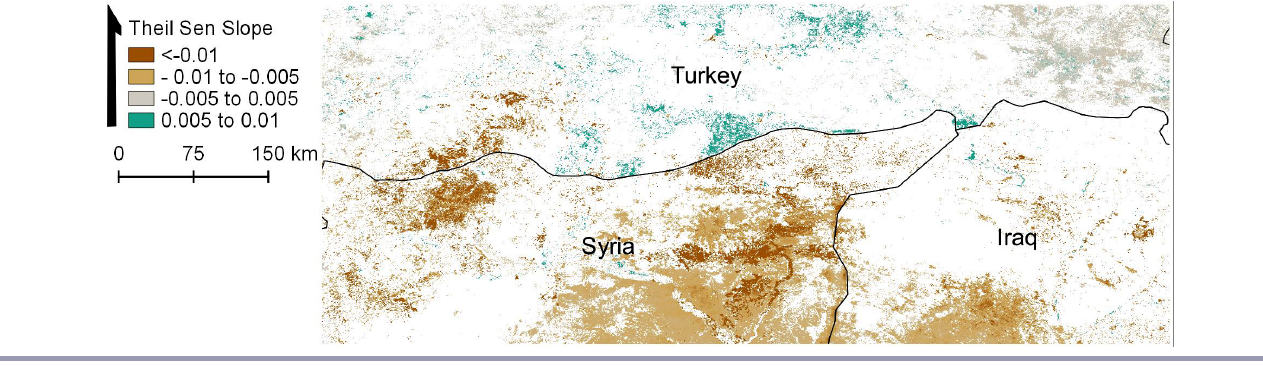
Fig. 2. Land productivity trends in the border region between Iraq, Syria, and Turkey 2001–2015, indicated by the Theil-Sen Slope of the Enhanced Vegetation Index (EVI). The values represent the average yearly change in EVI units, which means that a value of -0.01 represents a general decrease by 0.15 EVI units over the 15-y time period. Not significant areas ( p > 0.05) have been masked.